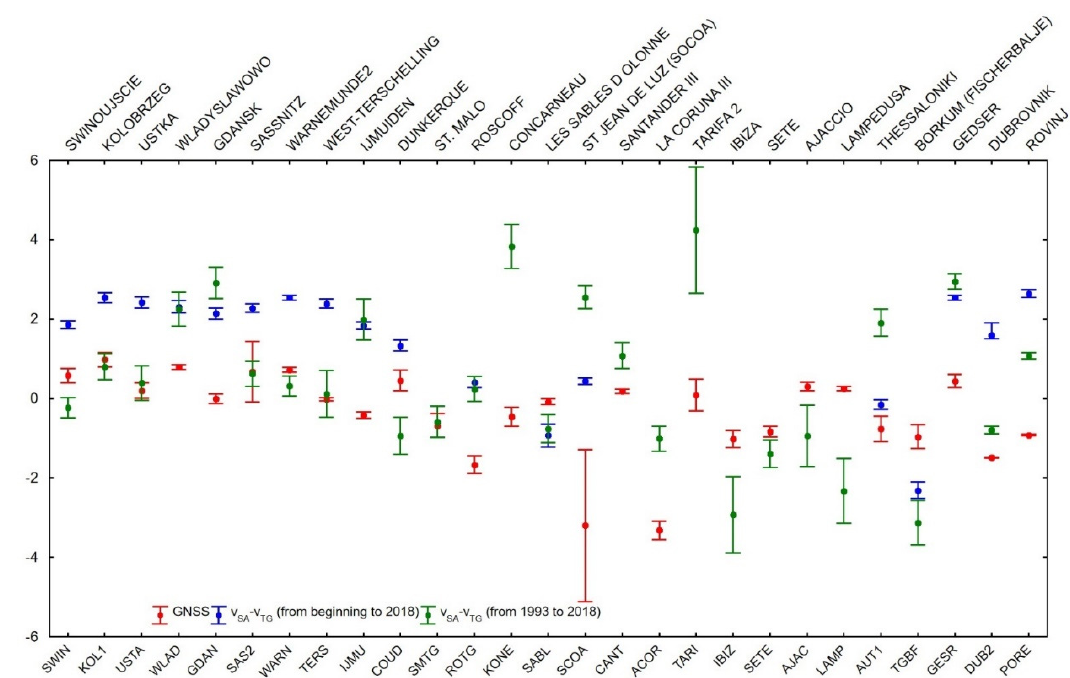
Figure 15. Vertical crust movements in TG sites along the European coast based on SA and TG data and the corresponding GNSS.